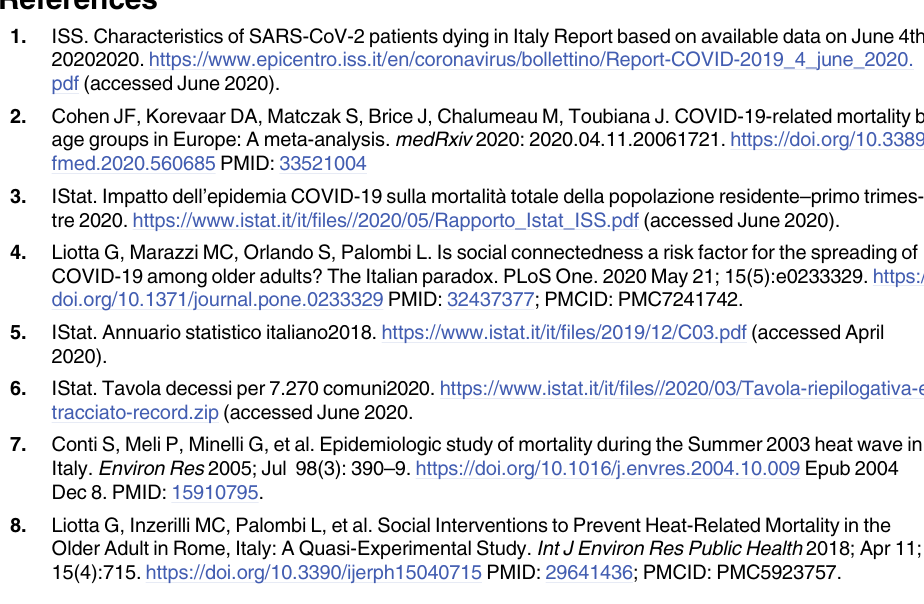
S1 Table. Death rate standardization (indirect